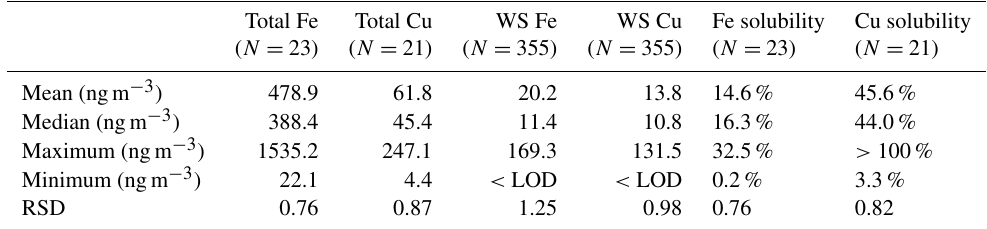
Table 2. Statistical summary of transition metal concentrations in PM 2 . 5 measured in Atlanta in 2017 based on liquid spectrophotometric (LWCC) measurement.